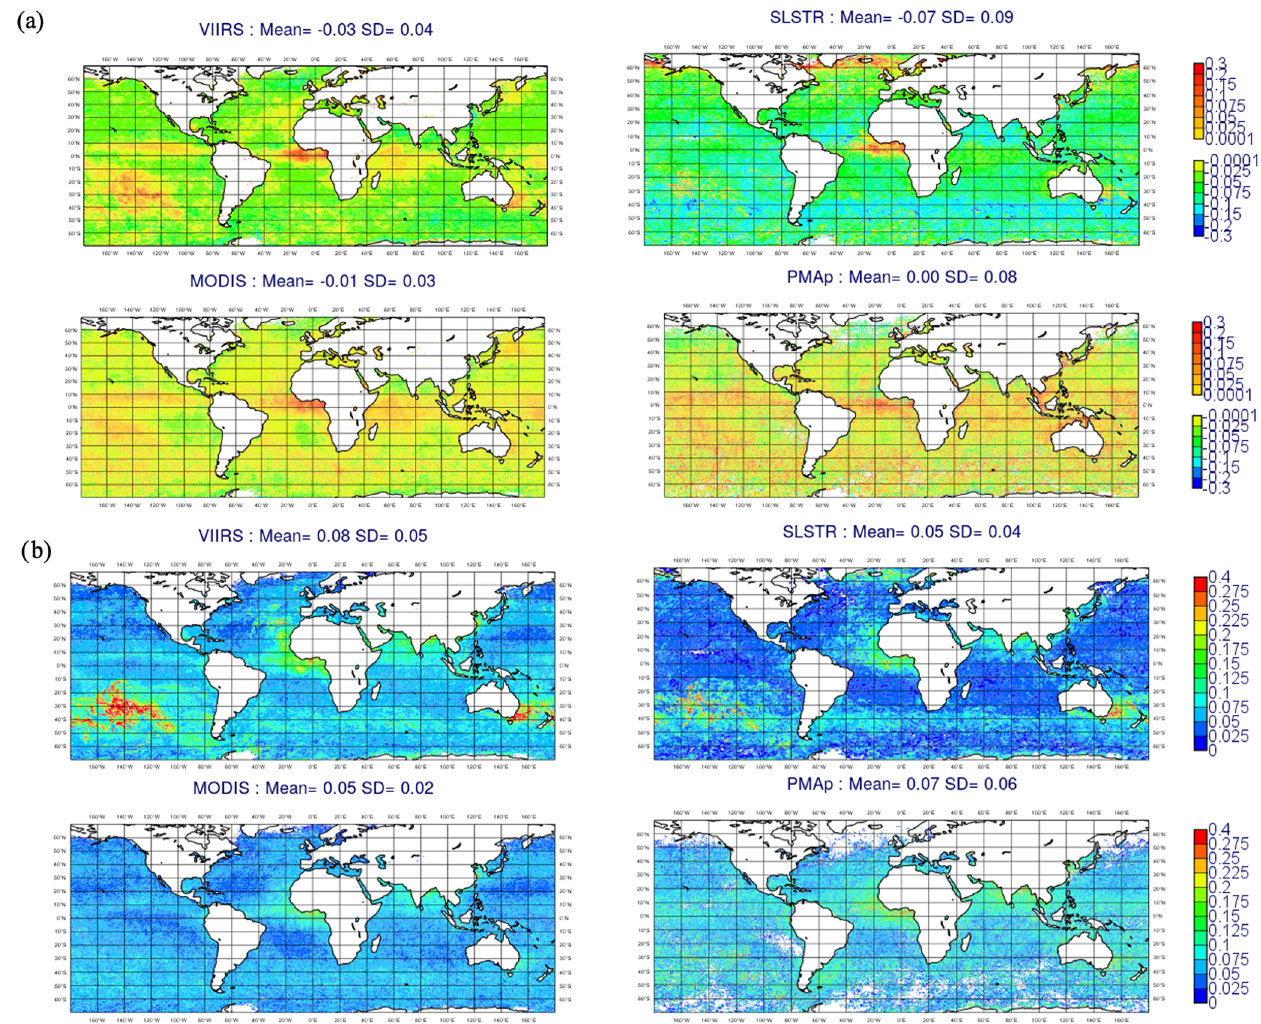
Figure 6. Global maps of the mean (a) and SD (b) of the first-guess departure from Terra and Aqua/MODIS, NOAA20 and SNPP/VIIRS, S3A and S3B/SLSTR, and MetOp-A/B–PMAp for the DJF (2019–2020) period over